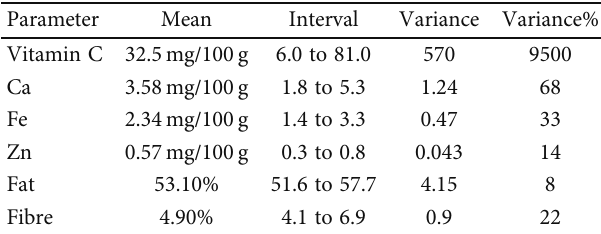
Table 2: Variation in nutrition composition of S. birrea fruit pulp and seed